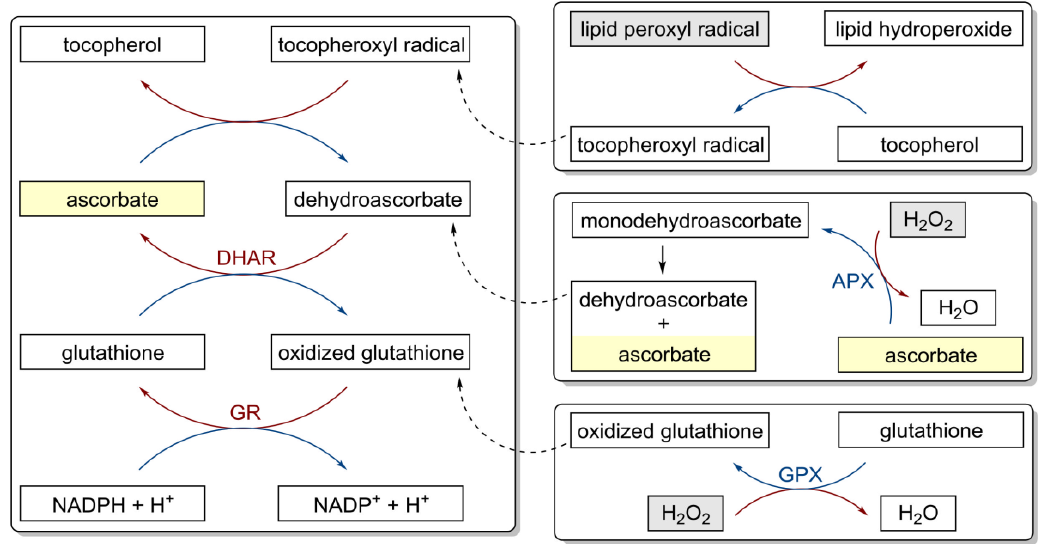
Figure 3. Antioxidant properties of vitamin C and redox cycling antioxidants. APX, ascorbate peroxidase; DHAR, semidehydroascorbate reductase; GPX, glutathione peroxidase; GR, glutathione reductase [86].